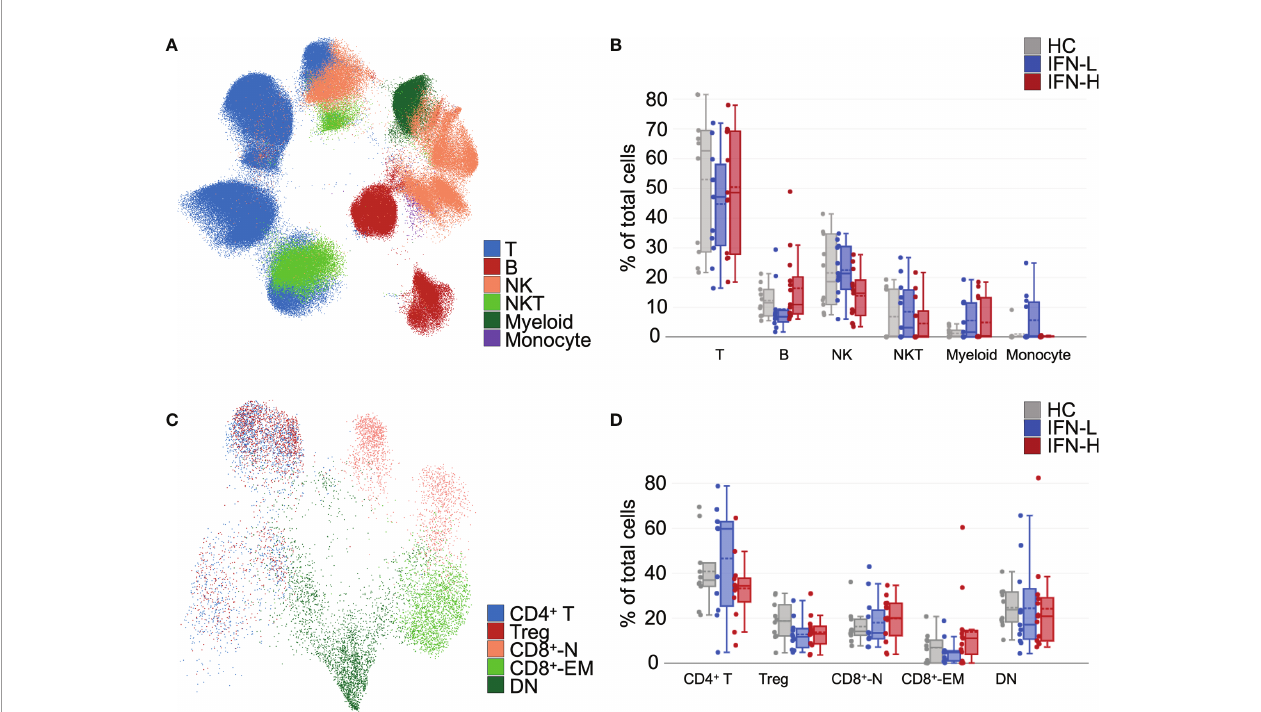
FIGURE 4 | (A-D) Unsupervised analysis of mass cytometry identi fi es differences in abundances of immune cell and T cell subsets in SLE patients subsetted on high or low IFN signature. (A) Unsupervised uniform manifold approximation and projection (UMAP) and FlowSOM algorithms were utilized in OMIQ, which yielded distinct clusters in pTOF panel identi fi ed T cells, B cells, NK cells, NKT cells, myeloid cells, and monocytes. (B) Abundances of immune cell subsets identi fi ed in (A) from unstimulated samples. (C) UMAP analysis of T cells identi fi es multiple T cell subsets (CD4 + T cells, Tregs, CD8 + -N = naïve CD8 + T cells, CD8 + -EM = effector memory CD8 + T cells, and DN = double negative T cells). (D) Abundances of T cell subsets identi fi ed in (C) from unstimulated samples. Tregs were manually gated in OMIQ on CD25 + CD127 -